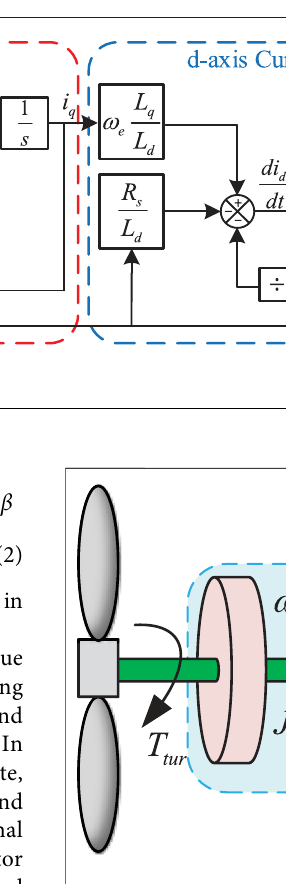
FIGURE 4 | Wind turbine two-mass